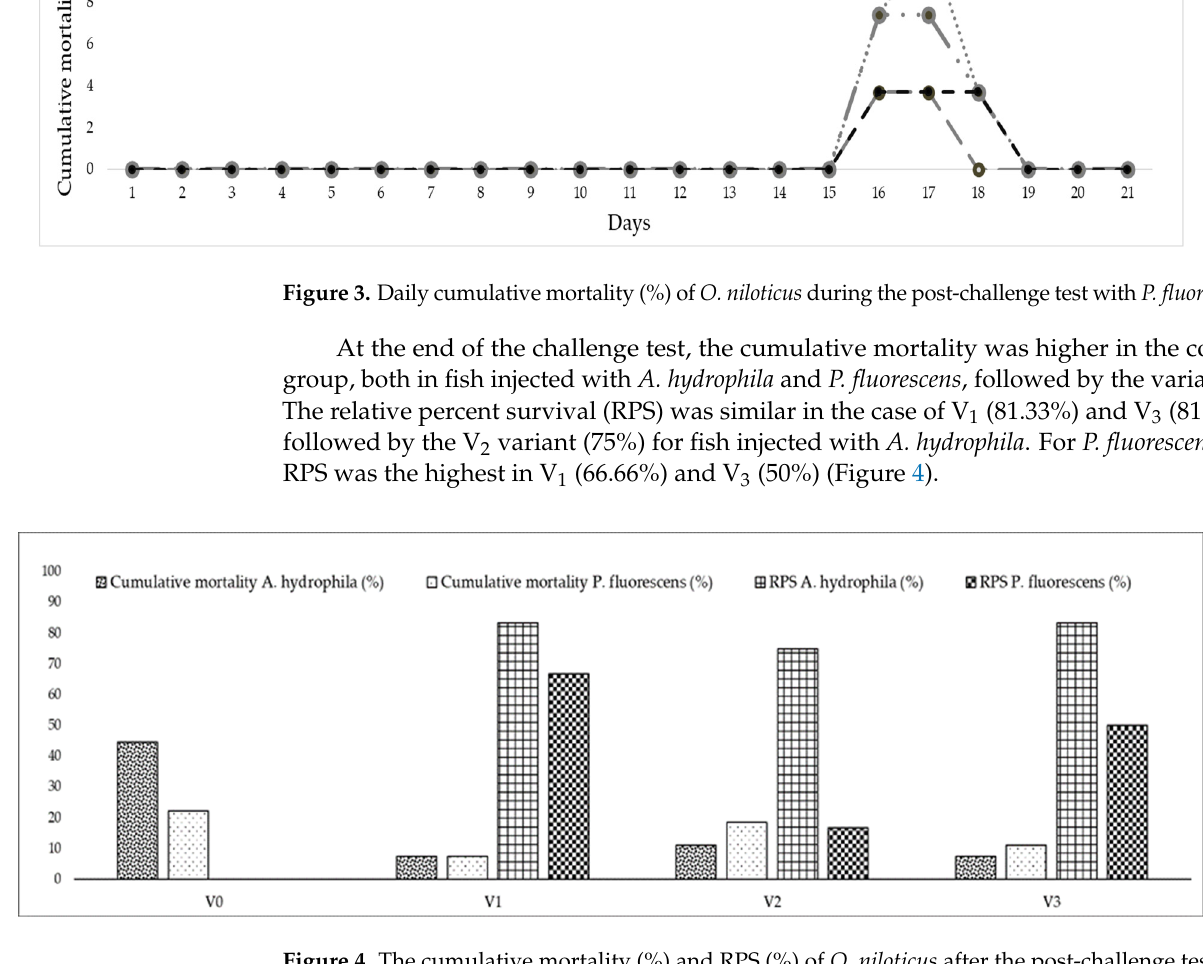
Figure 4. The cumulative mortality (%) and RPS (%) of O. niloticus after the post-challenge test. The dead and moribund fish affected with Aeromonas hydrophila showed signs of external hemorrhaging at the base of the fins, around the anus, and at the skin. Internal symptoms were observed, such as the bloating of the abdomen, the hemorrhaging of the peritoneum, the presence of ascitic fluid, and an enlargement of internal organs, especially of the gallbladder (Figure 5).